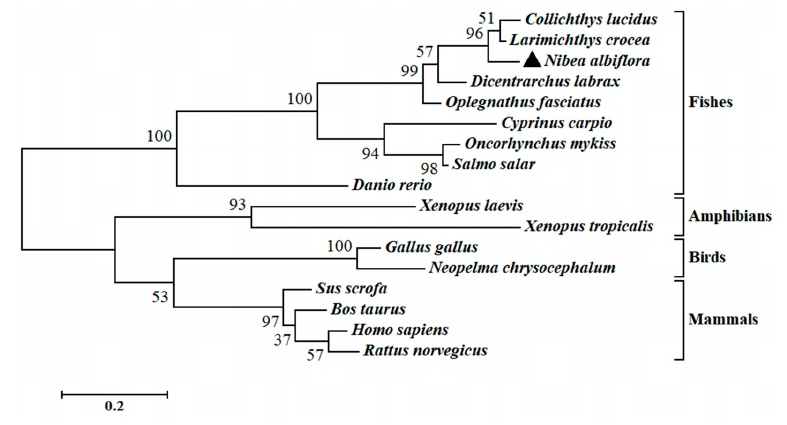
Figure 3. Phylogenetic analysis of Na Gal ‐ 1. N. albiflora is black triangled, the numbers at the nodes indicate the bootstrap confidence values (100%) of 1000 replicates, the scale bar (0.2) indicates the genetic distance, the GenBank accession numbers of amino acid sequences used are listed in Table 1. Table 1. Amino acid sequence identity between Na Gal ‐ 1 and Gal ‐ 1 of other